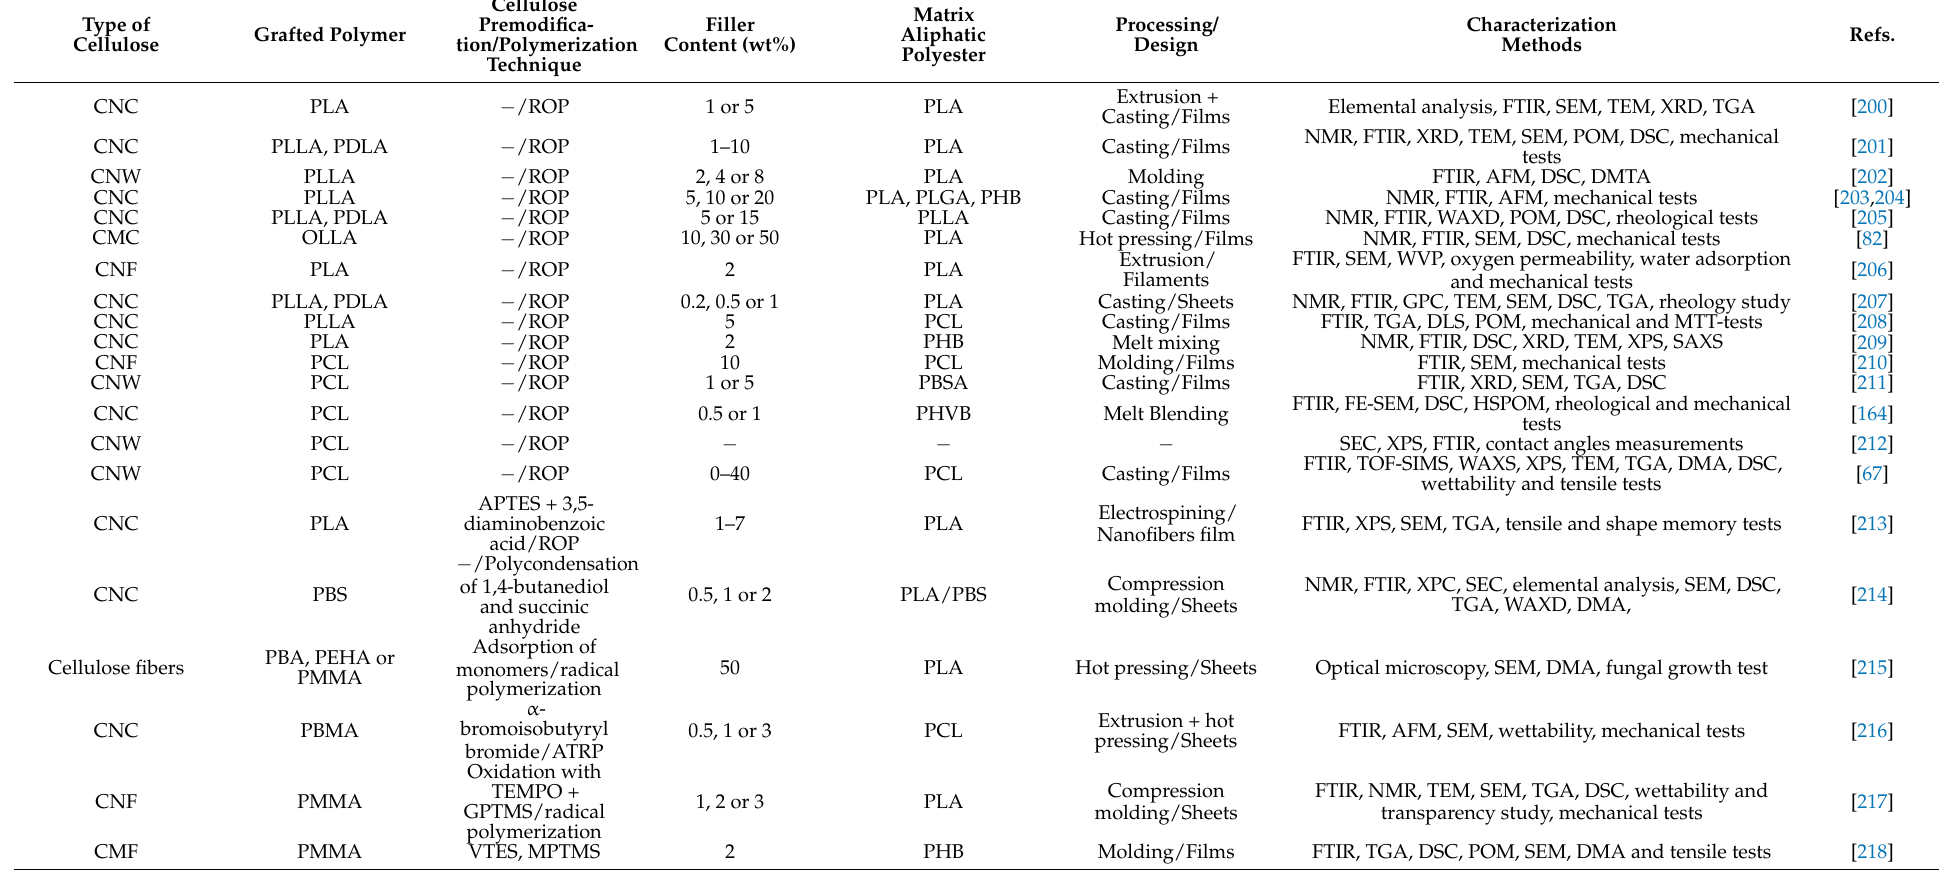
Table 8. Summary on covalent modification of cellulose micro- and nanomaterials by grafting “from”